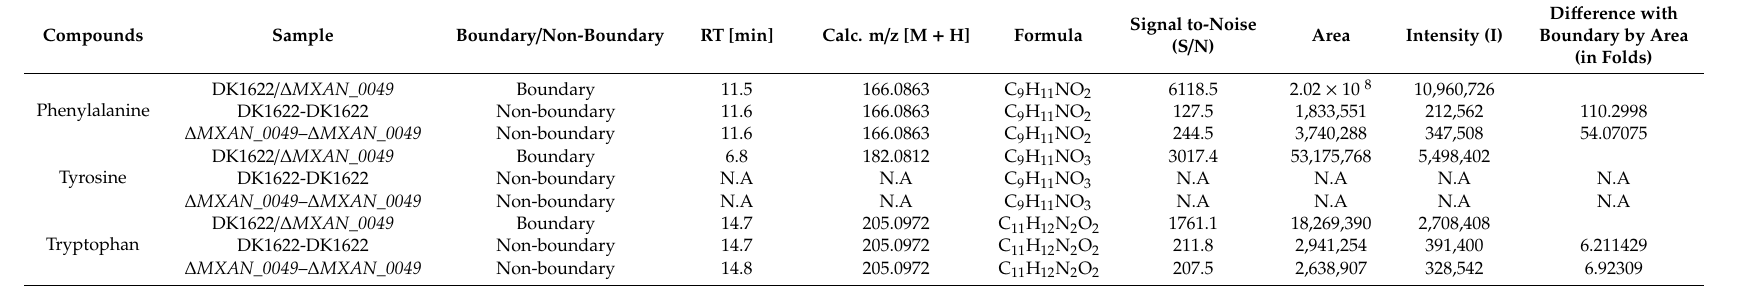
Table 3. Detection of phenylalanine, tyrosine, and tryptophan via